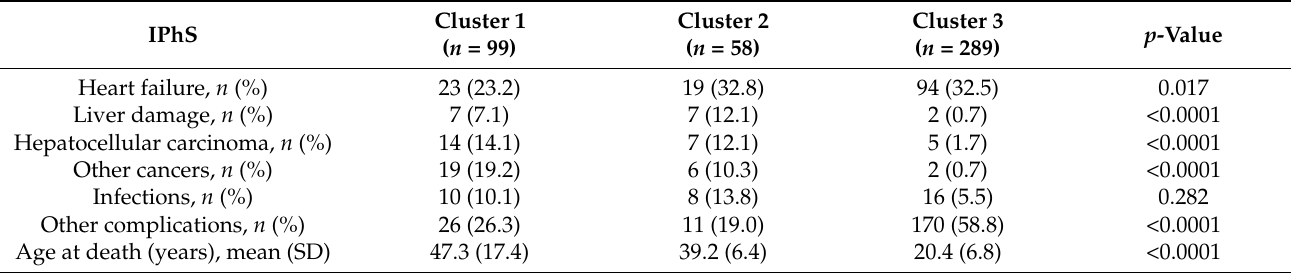
Table 4. Comparison of the causes of death between the three